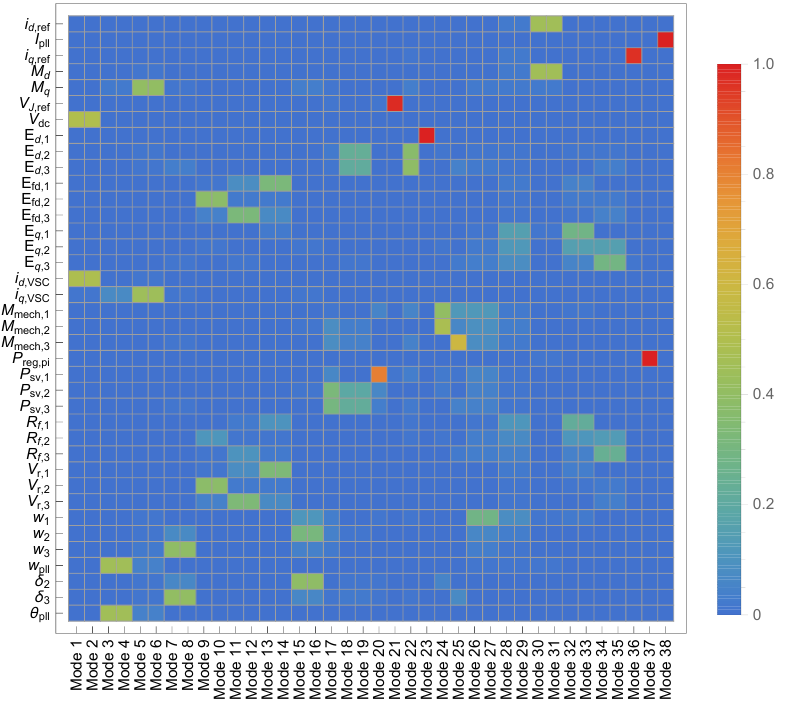
Figure A3. IEEE 9 bus: Matrix of Participation factors for the system with ROCOF